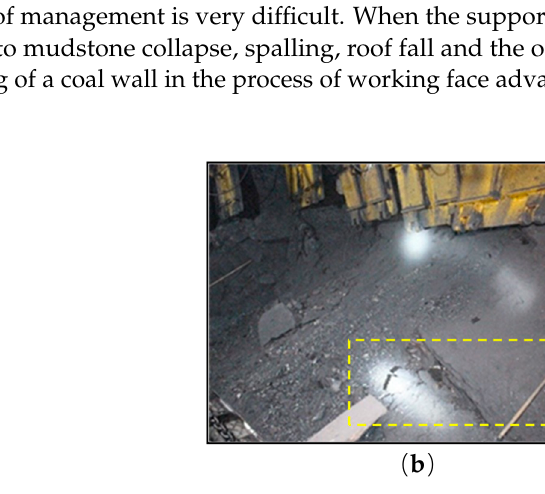
Figure 2. Failure diagram of working face. ( a ) Block collapse; ( b ) Support falling.